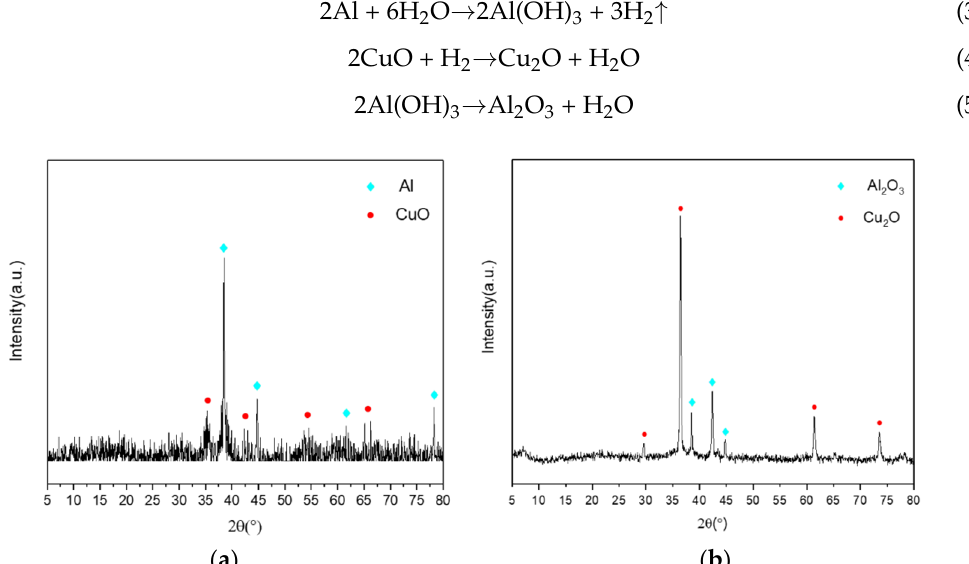
Figure 11. XRD patterns for ( a ) a holding time of 1 h and ( b ) 10 mL of deionized water.